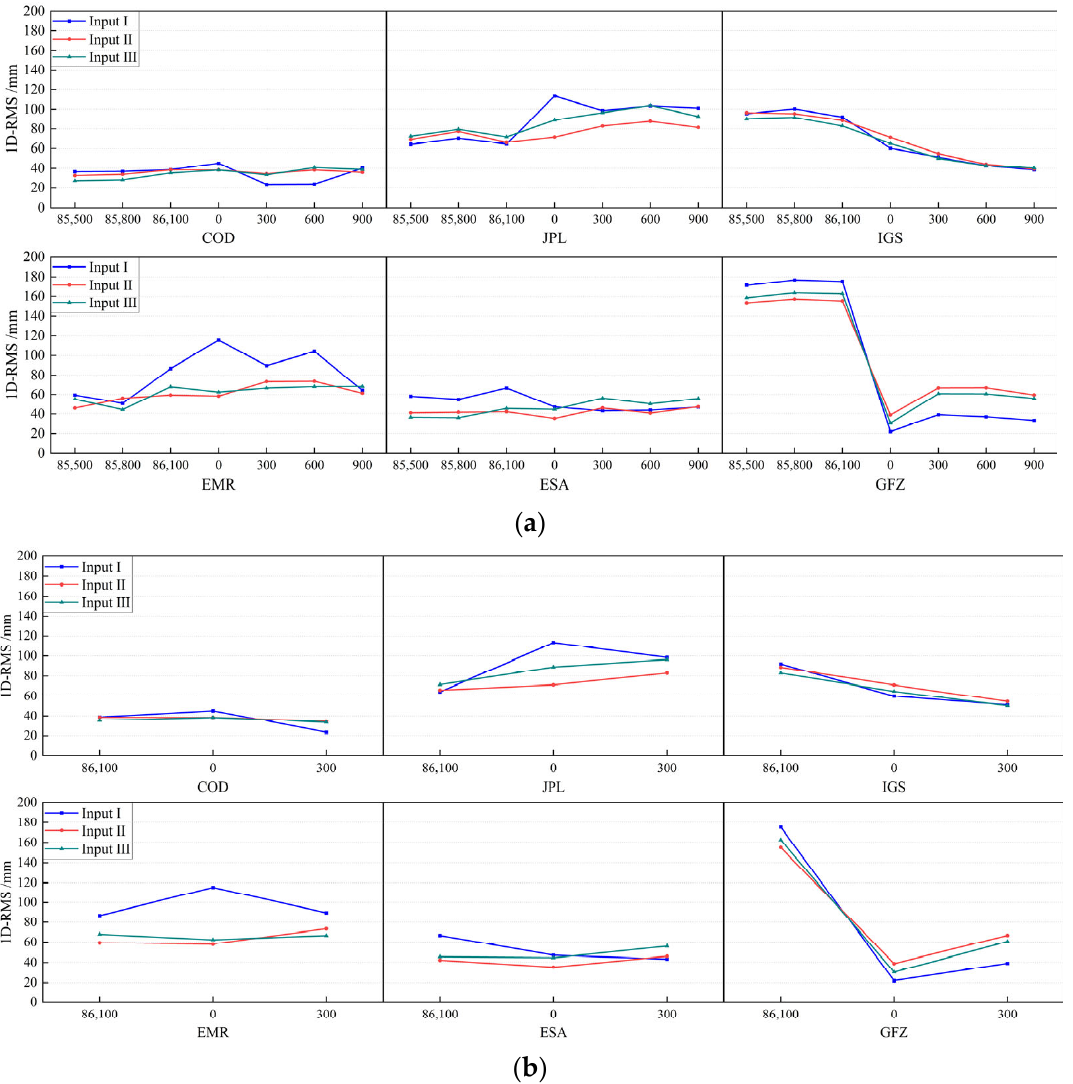
Figure 9. Time series near the daily boundary of the kinematic LEO orbit (unit: mm). The horizontal coordinate is seconds in days, and the vertical coordinate is 1D-RMS. ( a ) 15 min near the day boundary ( b ) 5 min near the day boundary.